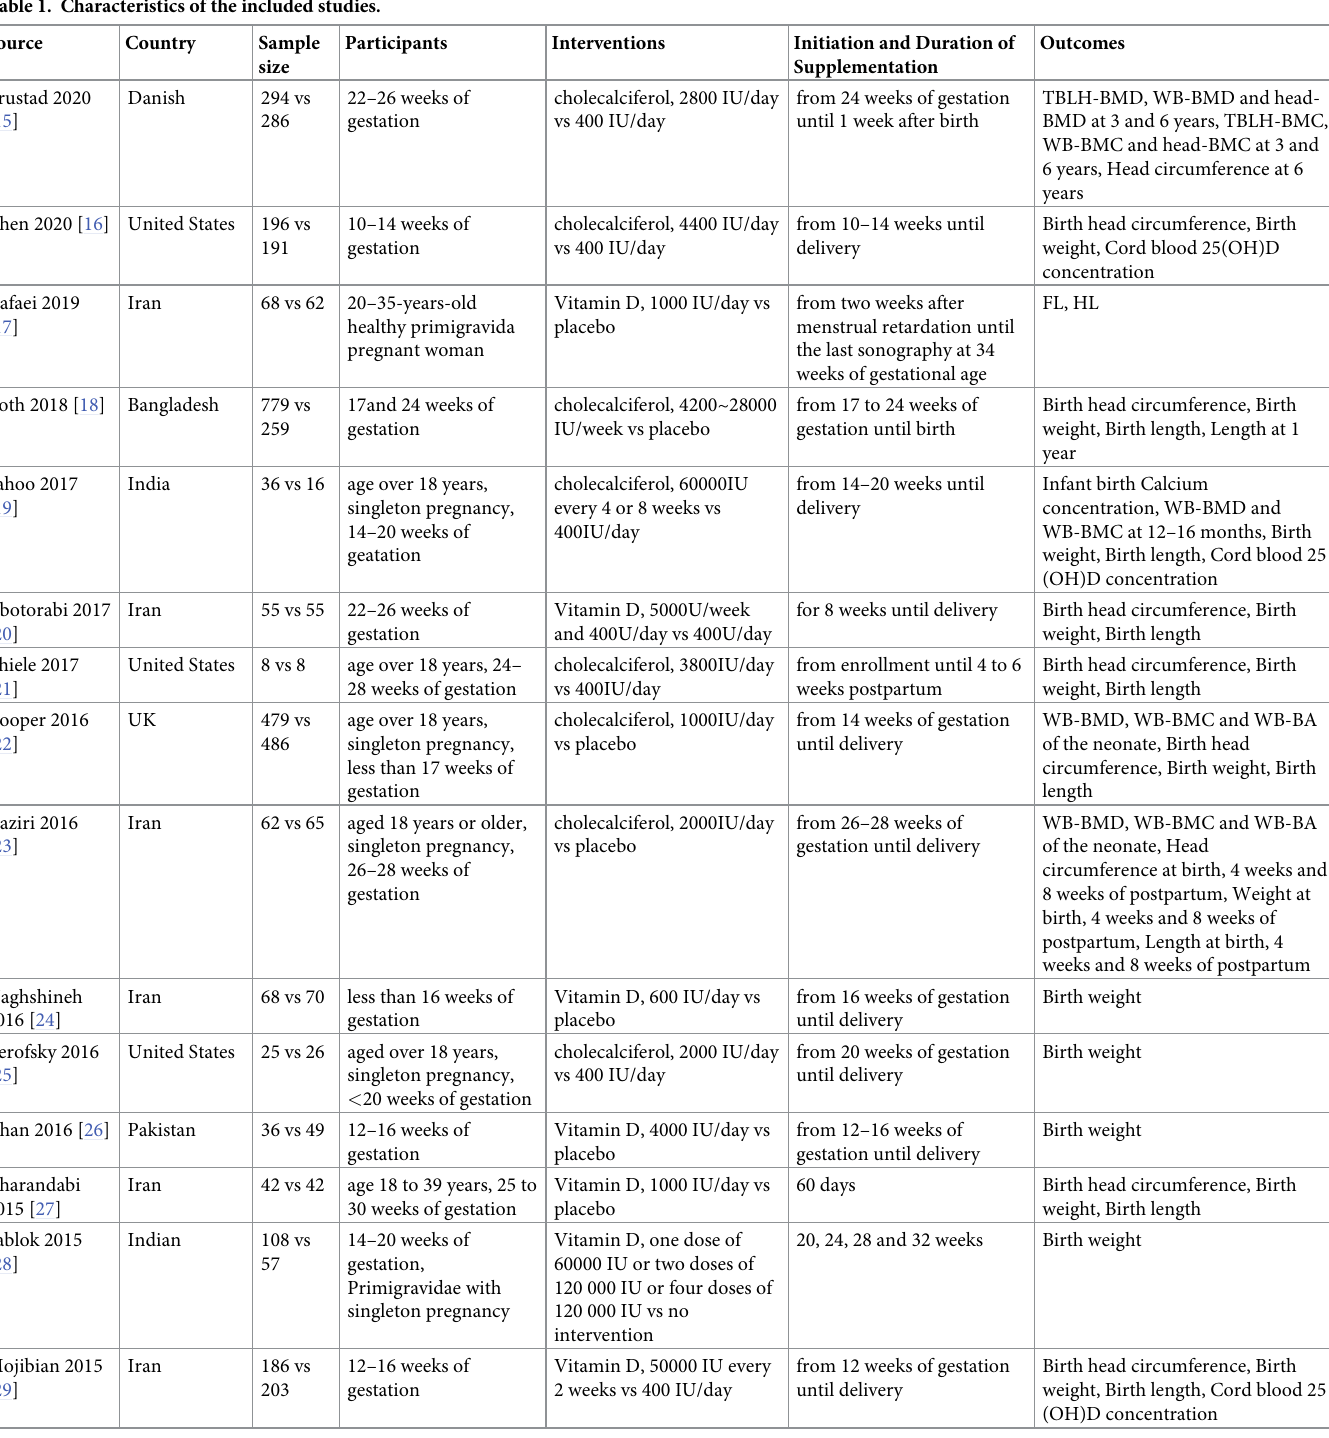
Table 1. Characteristics of the included